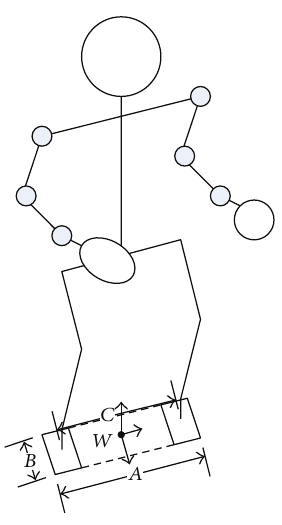
Figure 1: Humanoid robot